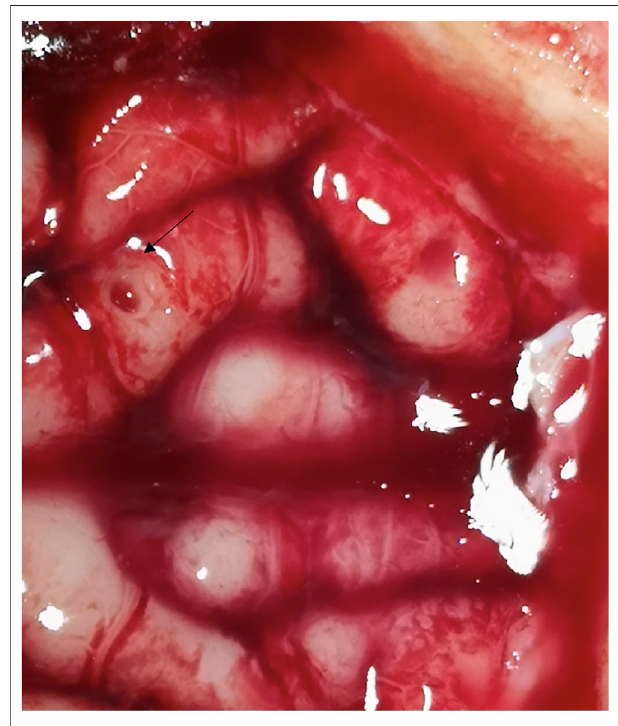
FIGURE 7 | Cortex damage after three laser beams with higher power settings